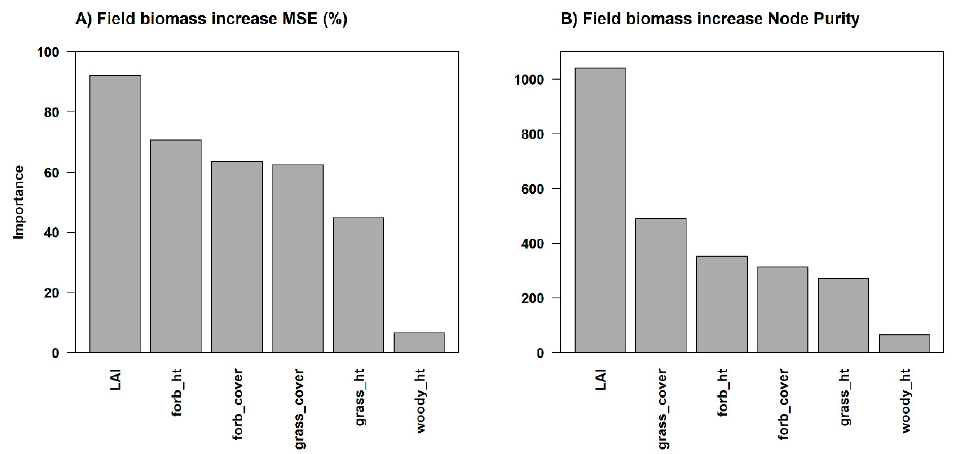
Figure 4. Variable importance plots from vegetation plots and final ceptometer-based biomass Random Forest models. The increase in ( A ) mean squared error (MSE) (%) and ( B ) node purity with a predictor variable iterated out of the model were used as an indicator of each variables importance.